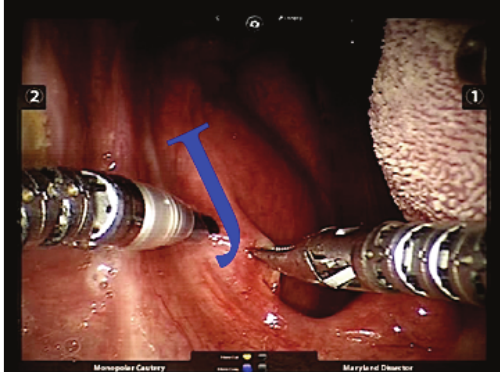
Figure 3: “J”-shaped incision on the anterior tonsillar pillar in order to obtain a wider and more detailed vision of the structures included in the upper portion of the PPS.